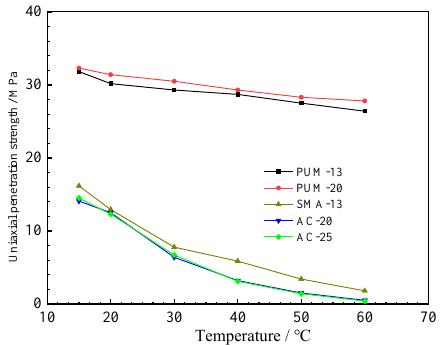
Figure 10. Uniaxial penetration strength results.